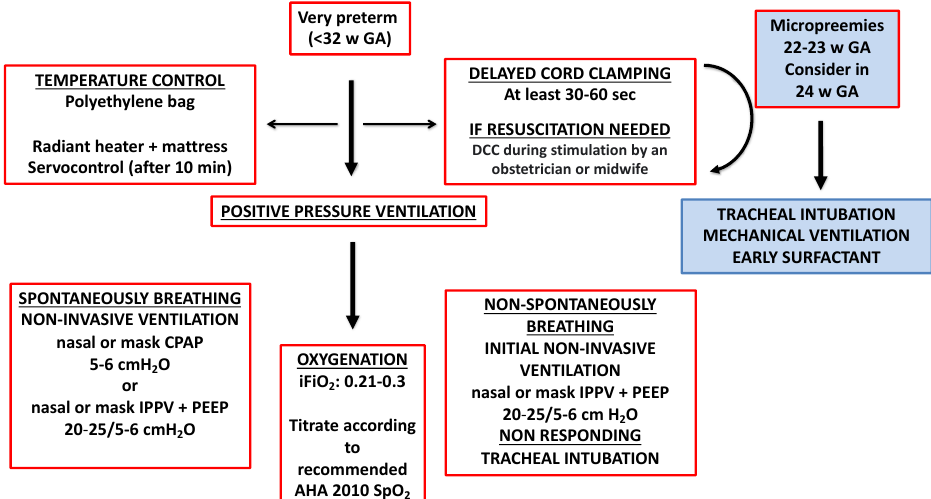
Figure 4. Suggested steps to be followed in very preterm delivery. The main issues in the delivery room are (i) maintaining an adequate body temperature and avoiding hypothermia; (ii) improving hemodynamics stability, delaying cord clamping, or including an obstetrician or midwife in the first seconds of neonatal stimulation; (iii) in spontaneously breathing babies, providing non-invasive ventilation with mask or nasal prongs CPAP, trying to avoid intubation. If the respiratory efforts are insufficient to achieve an adequate FRC, IPPV with PEEP should be provided. (iv) In apneic babies, initial non-invasive ventilation with IPPV and PEEP should be provided. If IPPV and PEEP are not efficient, intubation is required. (v) Initial FiO2 of 0.21 to 0.3 should be titrated using an air/oxygen blender according to HR and SpO2 response. Modified from Vento et al. Pediatr Respir